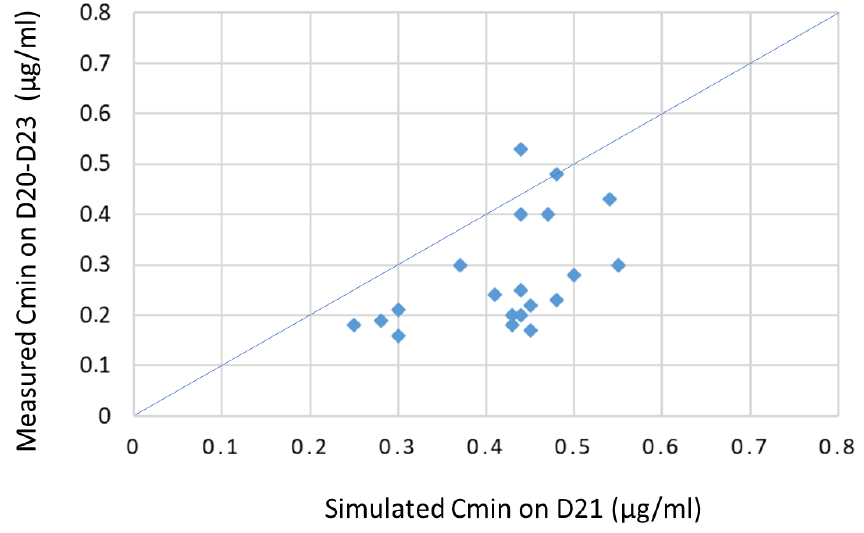
Figure 3. Actual vs. simulated trough levels in 20 patients. Measured Cmin were lower than simulated Cmin on D21 because the administration of most patients was performed up to 23 days after the previous course, thus lowering the measured concentration.